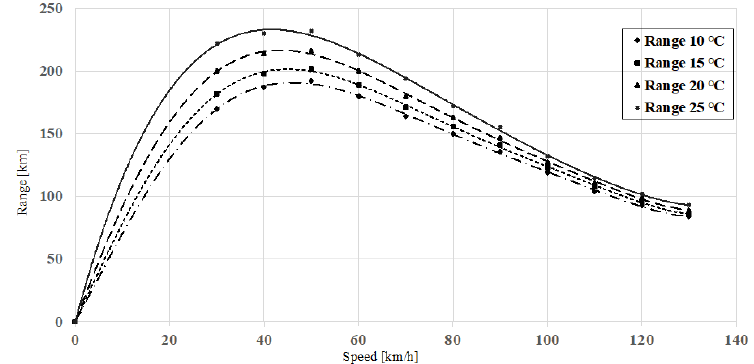
Figure 4. Electric vehicle characteristics: range vs. speed vs. temperature. The lines for each temperature are presented by polynomial linear regression with a degree of seven, which has the maximum R-squared value, with an average of 0.998, sug- gesting that this curve is the most similar to the real one. Equation (1) gives the R for 10 °C with respect to average speed (V), while (2)–(4) relate to the temperatures of 15 °C, 20 °C, and 25 °C respectively: